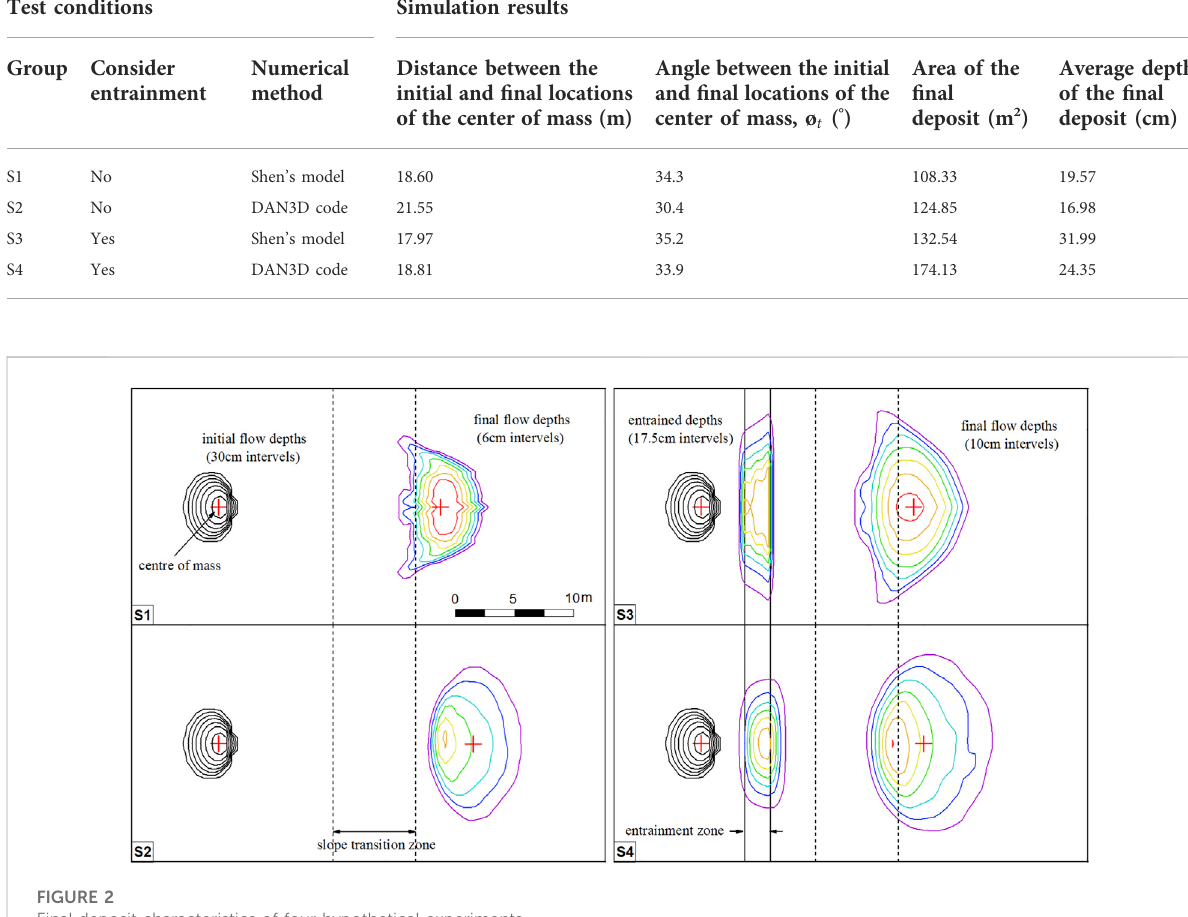
TABLE 1 Test conditions and simulation results.